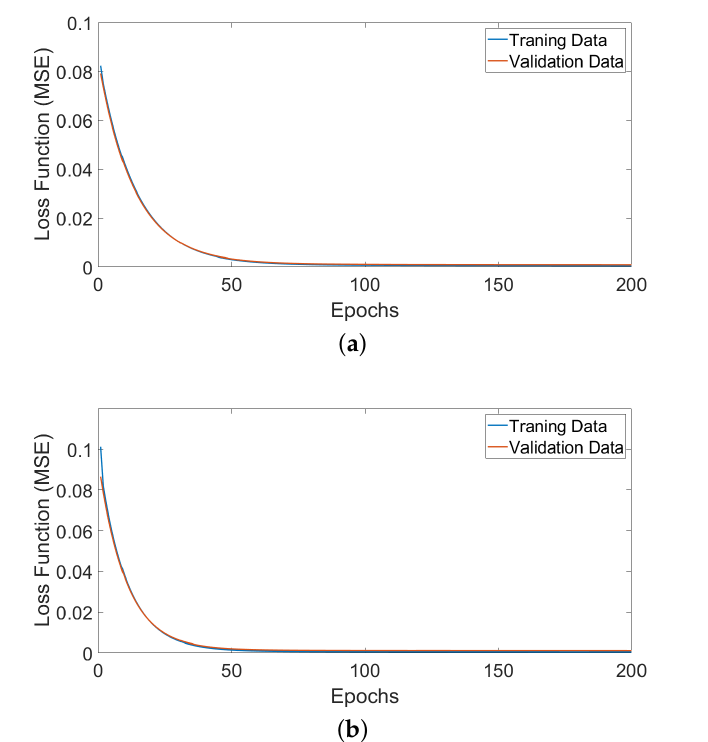
Figure 9. The convergence plot between the loss function of the training and validation sets while training the CNN of JNJ stock. ( a ) Half-day trading delay ( m = 43). ( b ) One-day trading delay ( m = 79).